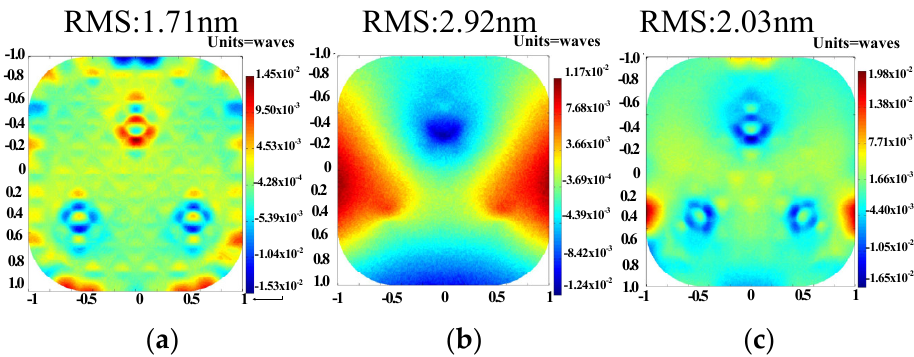
Figure 12. The results show that the surface of the mirror assembly under different working conditions when (cid:15) = 117.5. ( a ) 1 g gravity, ( b ) 0.08 mm forced displacement, and ( c ) 4 °C temperature.